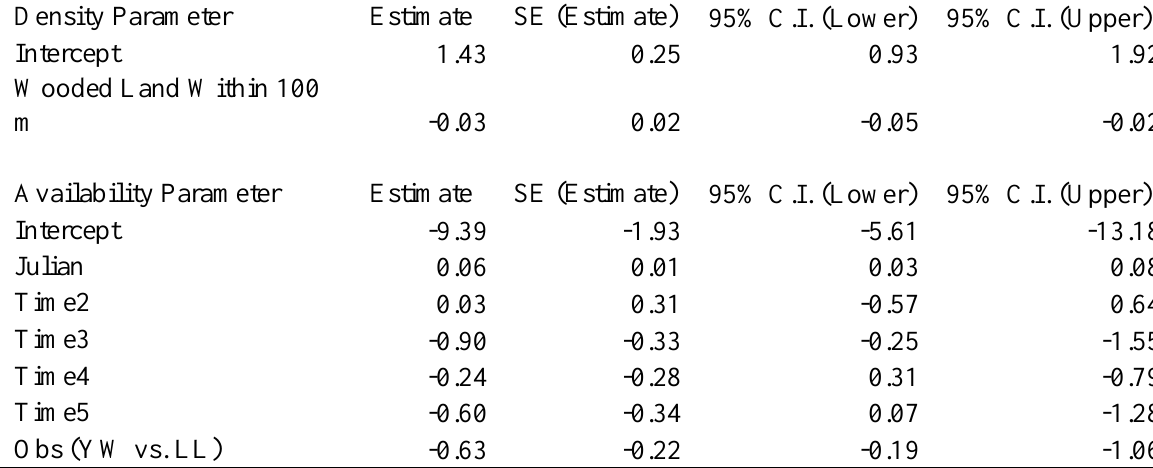
Table A2.K . Final hierarchical distance-sampling model for Savannah Sparrows along 46 transmission line study sites in Winnipeg, Manitoba, Canada in 2008 (n=138 surveys), assuming a uniform detection probability with increasing distance of birds from the transect line and effects of Julian date, time of morning and observer experience on availability for